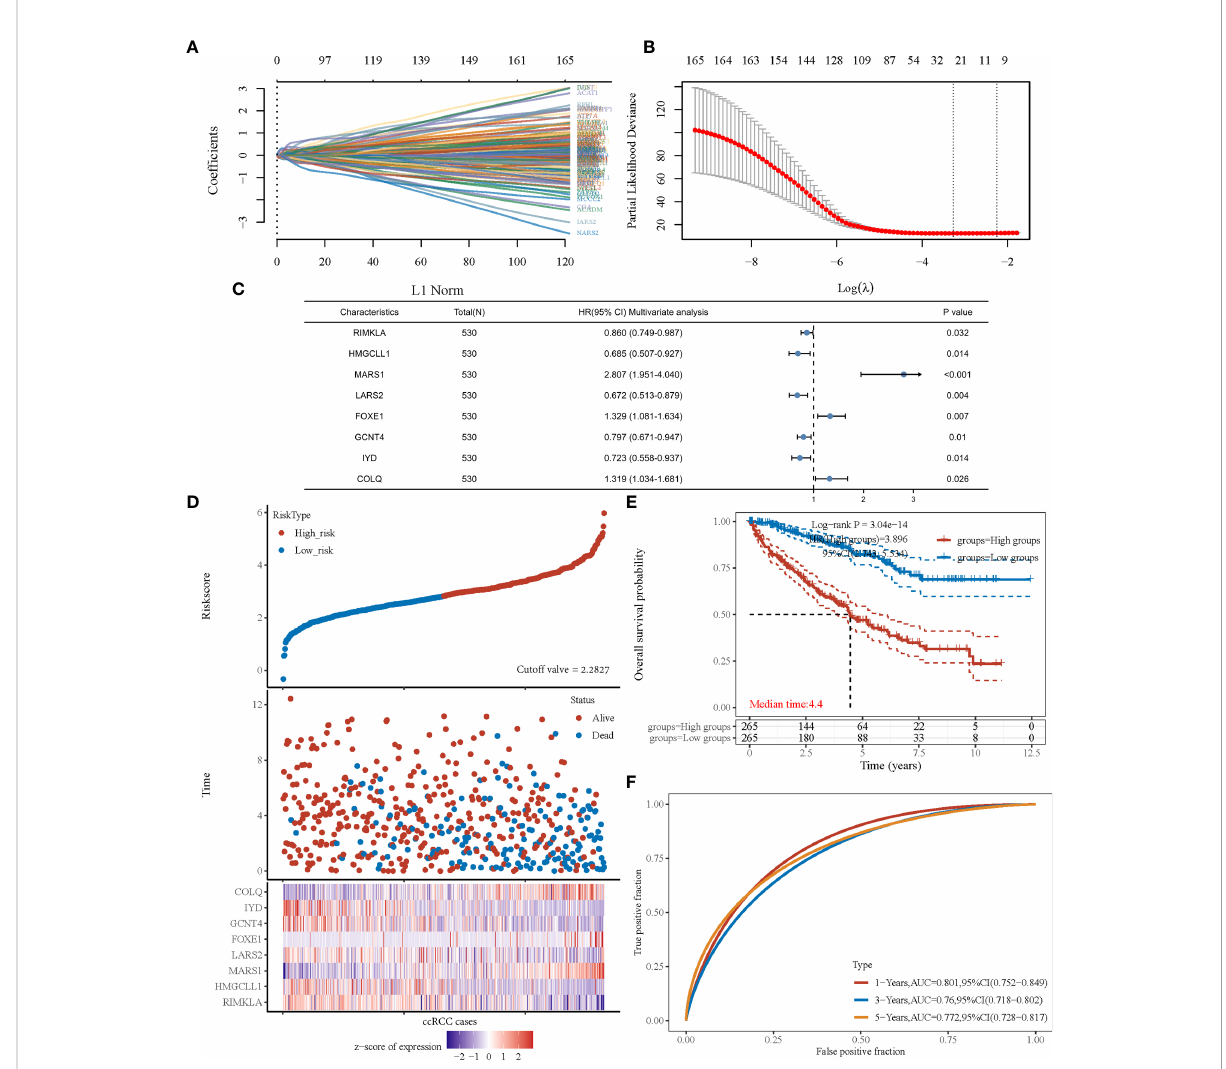
FIGURE 2 The prognostic signature was established based on eight prognostic amino acid metabolism-associated genes. (A) LASSO coef fi cient pro fi les of the genes associated with the amino acid metabolism of ccRCC. (B) Partial likelihood deviance is plotted versus log ( l ). (C) Forest plot of multivariate COX analysis of eight genes involved in the signature. (D) The risk score of each sample based on the amino acid metabolism- associated signature. Patients were divided into low- and high-risk groups according to the median value of the risk score. The high/low expression of eight genes that were involved in the prognostic signature are shown in red/blue in each sample. (E) Kaplan – Meier curve of overall survival differences strati fi ed by signature risk score. (F) The ROC curves of the signature for overall survival at 1, 3, and 5 years. LASSO, least absolute shrinkage and selection operator; ROC, receiver operating